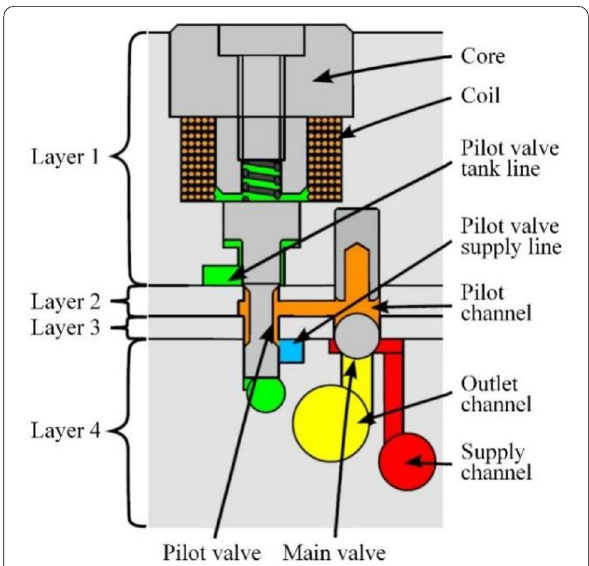
Figure 12 Pilot operated miniature valve designed by Lantela et